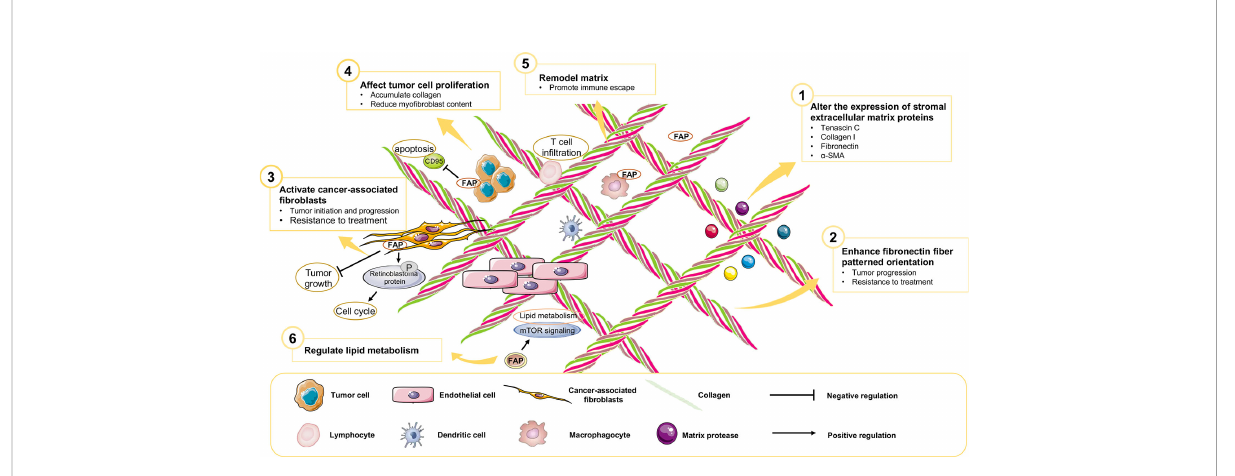
FIGURE 4 The role of FAP in the PAAD tumor microenvironment.